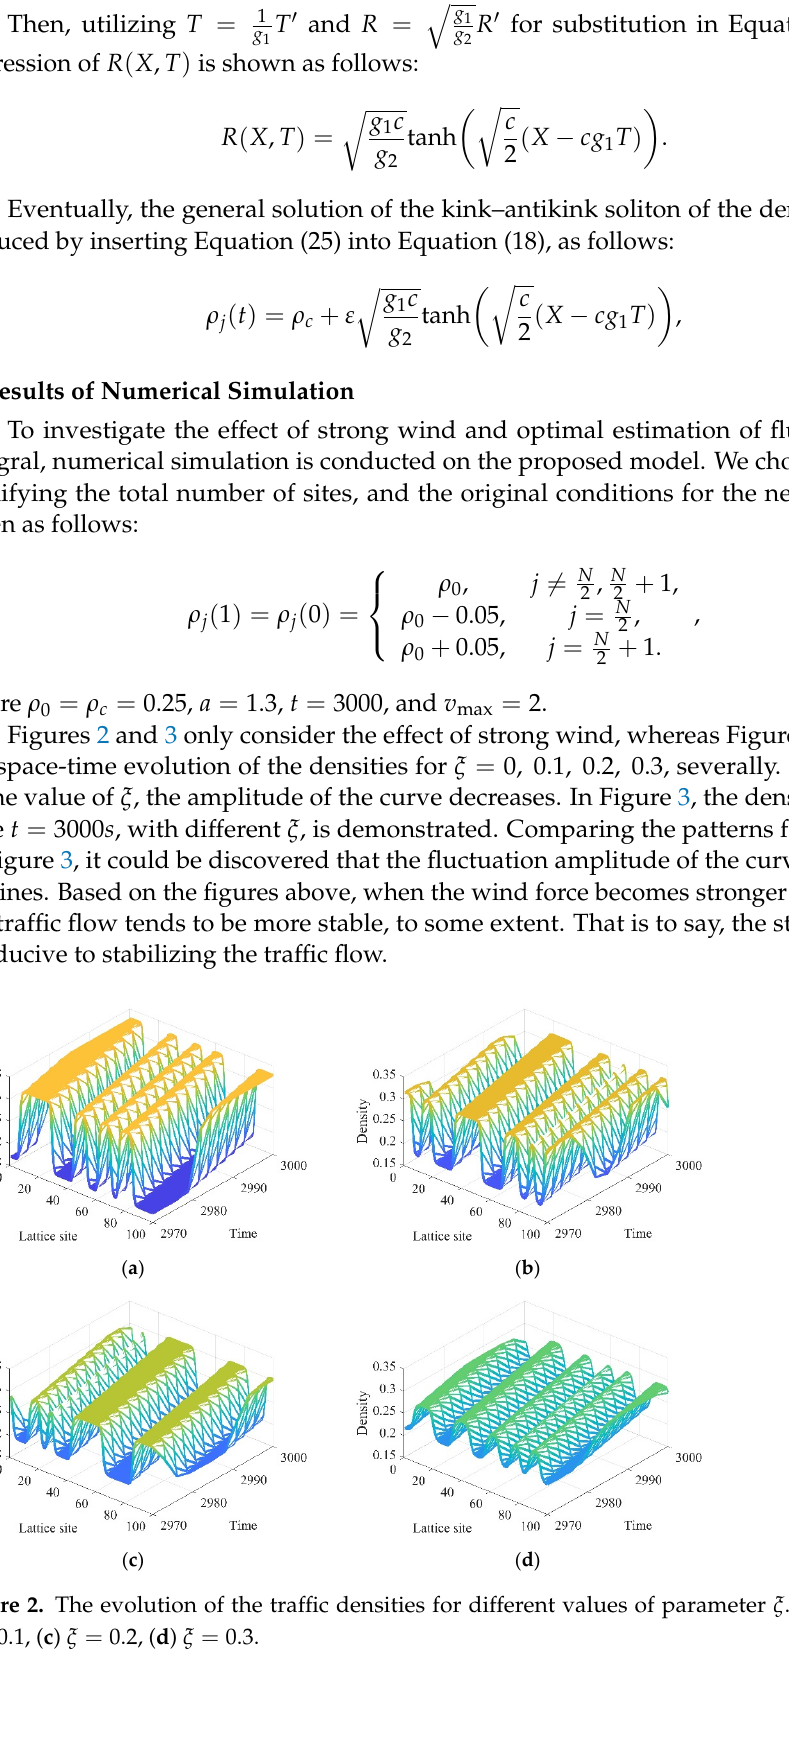
( a ) ( b ) ( c ) ( d ) Figure 3. The density profile at 3000 t s = under the different values of ξ . ( a ) 0 ξ= , ( b ) 0.1 ξ= , ( c ) 0.2 ξ= , ( d ) 0.3 ξ= .